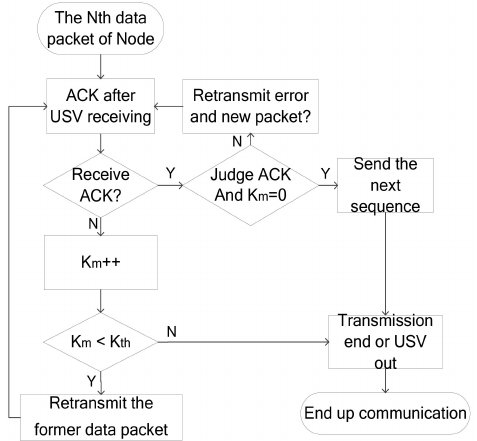
Figure 4. Flow diagram of data collection